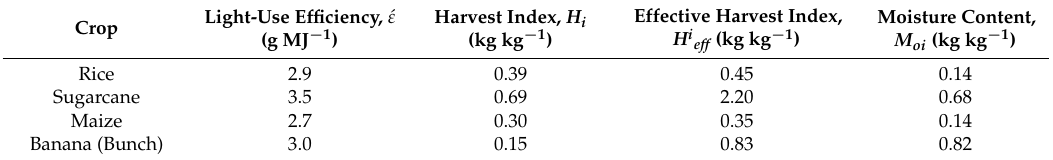
Table 3. Calibrated crop biomass parameters from calibration against secondary data and their ranges reported in the literature.